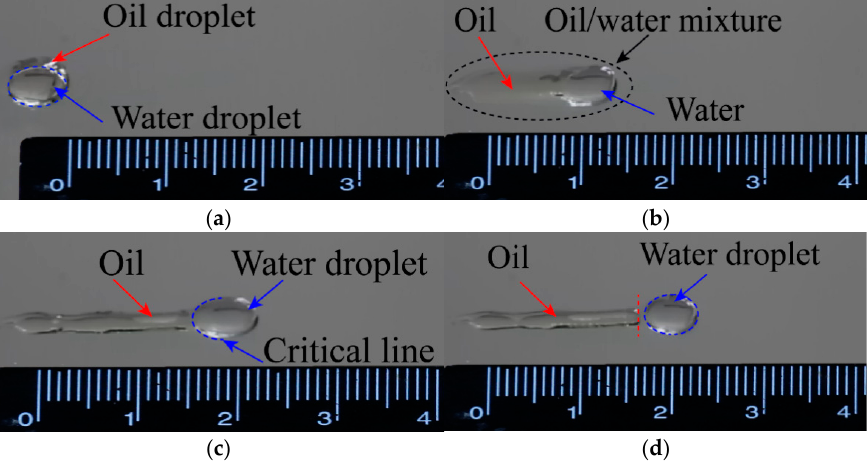
Figure 4. The process of an oil/water mixture separation. ( a ) The oil/water mixed drop. ( b ) The motion of oil/water mixed droplet on the mirror substrate. ( c ) The water droplet will be separated from the oil/water mixture until in a critical line. ( d ) The water droplet is separated from the oil/water mixture. Reproduced from Ref. [96]. The dot line in blue is the contour outline of water droplet, and the dot line in red represents the edge position of